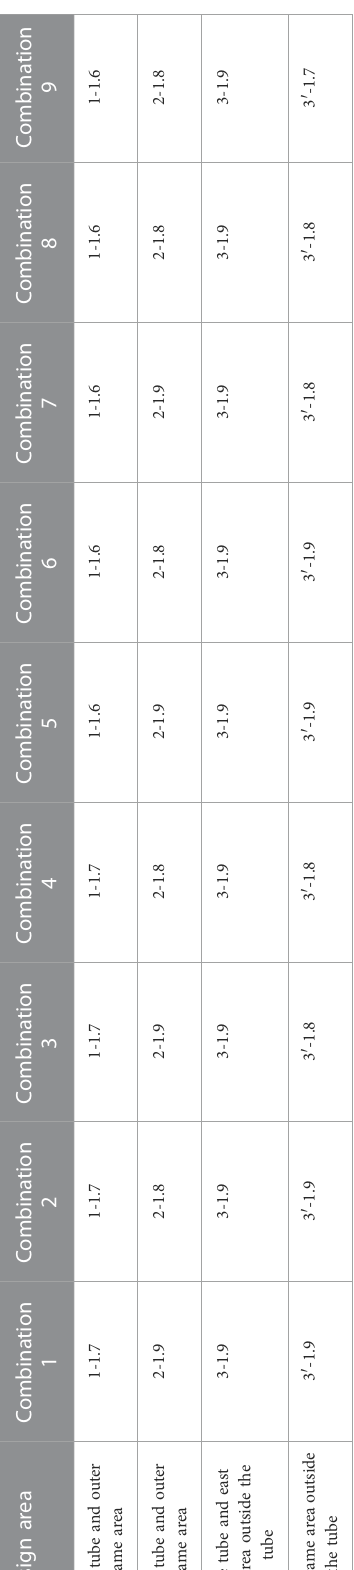
Note: s -Final deformation of foundation, mm ; s ′ -Foundation deformation calculated by layer summation method, mm ; ψ s -Empirical coef fi cient for settlement calculation; n -Number of soil layers divided within the calculated depth range of foundation deformation; p 0 -The additional stress at the bottom of the foundation corresponding to the quasi permanent combination of actions, kPa ; E si -Compressive modulus of the i th layer of soil under the foundation bottom, kPa ; z i , z i − 1 -Distance from the bottom of foundation to the bottom of soil layer i and i- 1, m; (cid:1) α i , (cid:1) α i − 1 -Average additional stress coef fi cient within the range from the calculation point of foundation bottom to the bottom of layer i soil and layer i -1 soil. T A